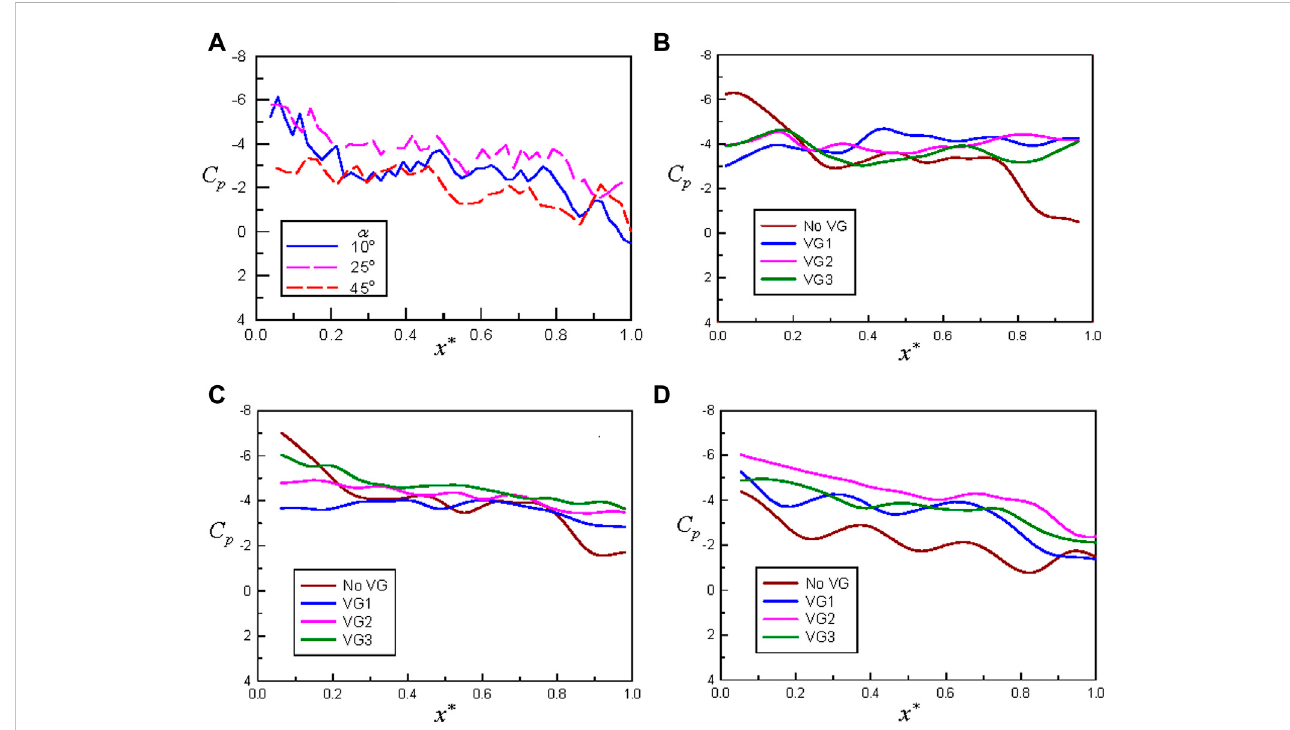
FIGURE 7 Variationofthepressurecoef fi cientalongthestreamwisedirection: (A) Themodelwithoutanalula-likevortexgeneratoratdifferentanglesofattackand y * = 0.44, and (B – D) comparison for the model with/without an alula-like vortex generator at y * = 0.44 and angles of attack of 10 ° , 25 ° , and 45 ° , respectively.